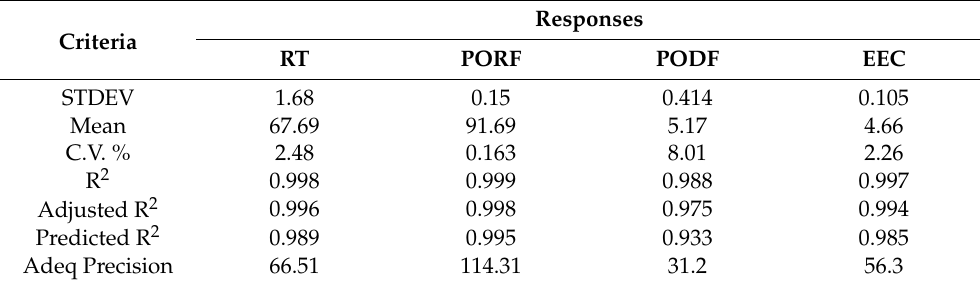
Table 3. The evaluation criteria, i.e., standard deviation (STDEV), Mean, coefficient of variation percentage (C.V. %), coefficient of determination (R 2 ), adjusted R 2 , predicted R 2 , and Adeq Precision criteria for the selected quadratic models for the required time for fruit ripening (RT), the percentage of ripened fruit (PORF), the percentage of damaged fruits (PODF), and the electrical energy consumption (EEC) responses